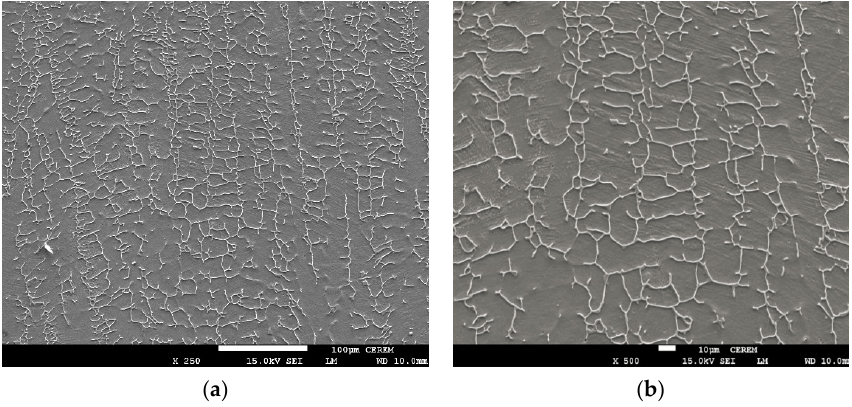
Figure 9. SEM micrograph in TIG fusion zone of 316L ( a ) (250×), ( b ) (500×).